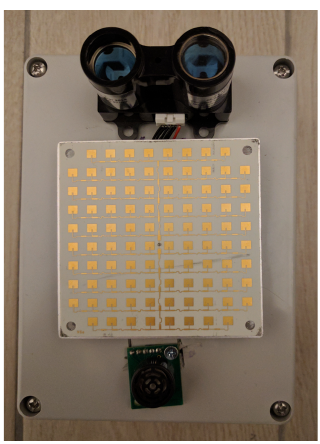
Figure 6. Second Experimental setup